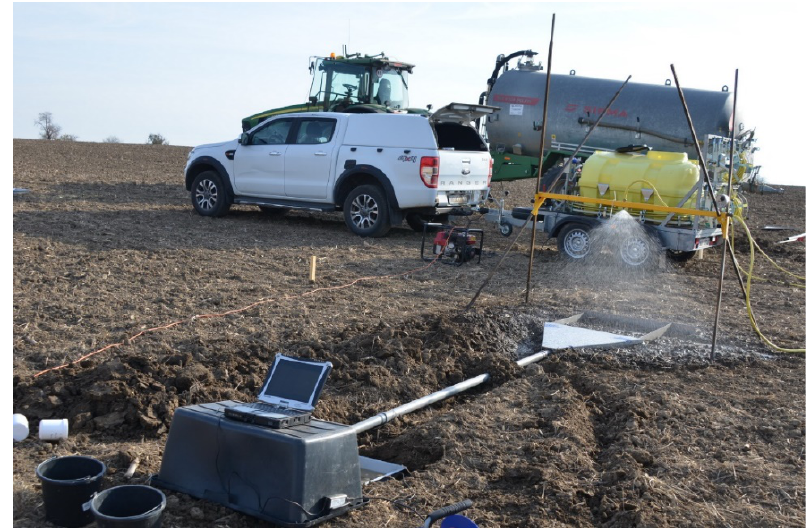
Figure 3. Rain simulator: a frame having a nozzle and an assembly for sampling water runoff.